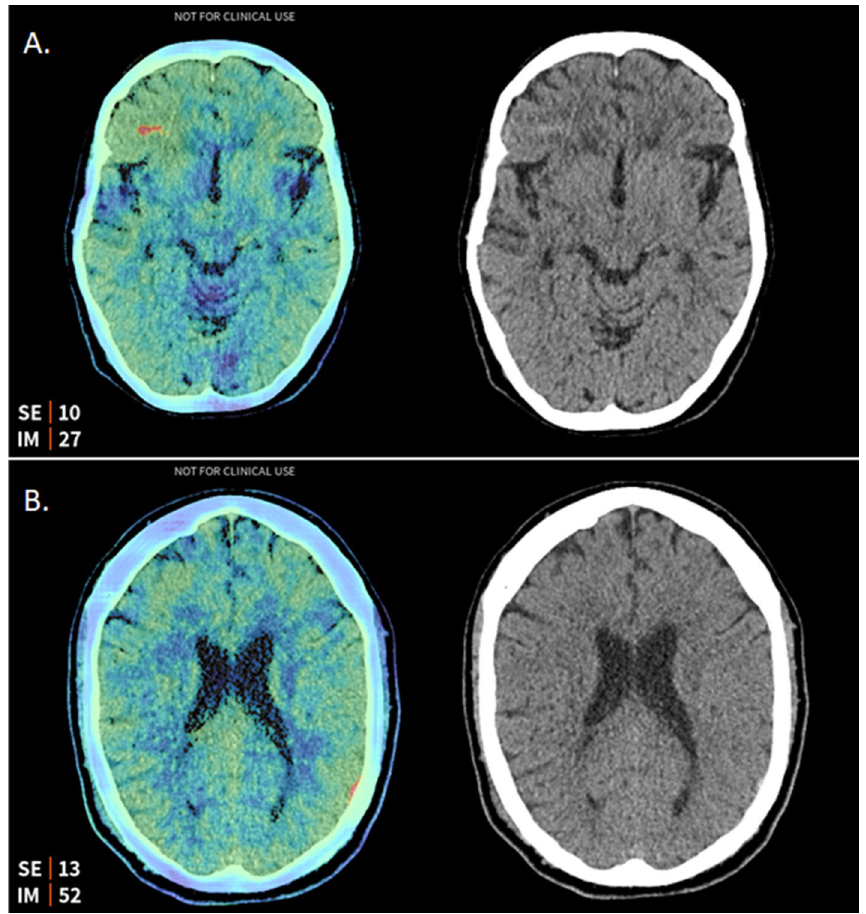
Figure 2. Two missed ICH detected by Aidoc. The key slices [right] and the saliency map generated by Aidoc [left] of the missed ICH identified by the audit; ( A ) a subarachnoid haemorrhage in the inferior right frontal lobe; and ( B ) a trace of extra-axial blood in the left parietal region.